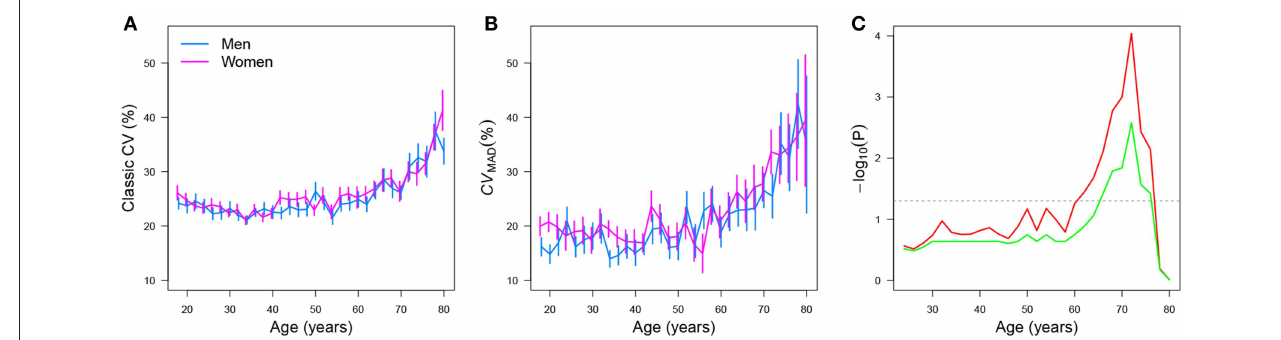
FIGURE 14 | Mean and standard error for the simple RT classic CV, by gender, as a function of age when the (A) classic and (B) CV MAD estimators of the CV are log 10 ( P ) for the structural change test as a function of age. Here, the value P indicates the p -value obtained by performing the test. Raw used. The plot (C) shows − and FDR-corrected p -values are shown in red and green, respectively. Values above the gray horizontal line are significant at 5%.